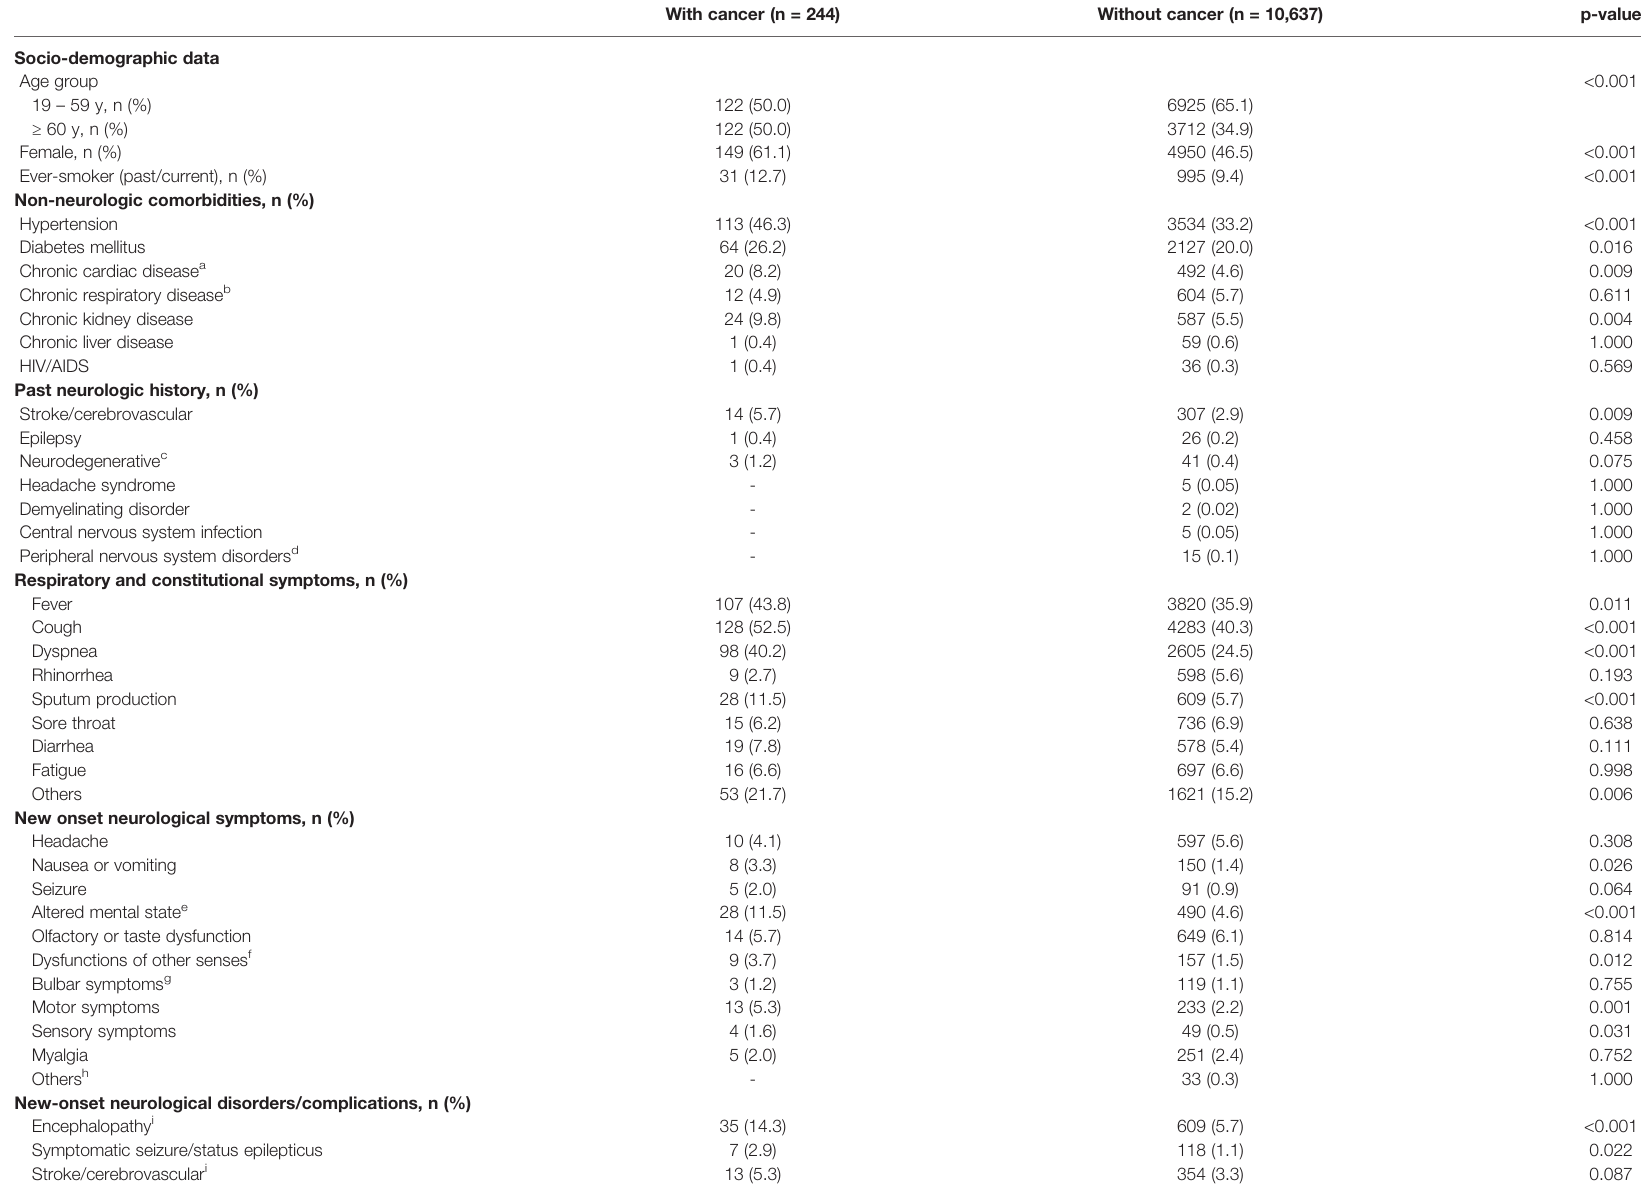
TABLE 1 | Clinicodemographic characteristics of the strati fi ed according to having cancer or